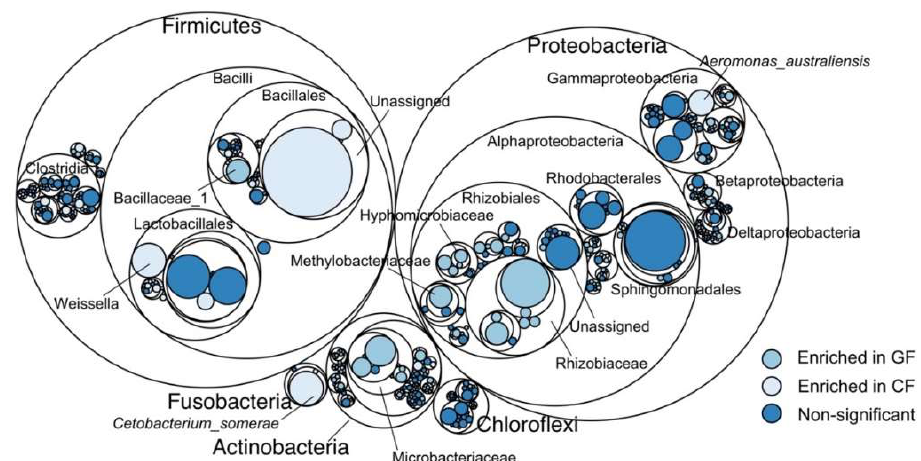
Figure 3. Maptree plot descriptions of the taxonomic differences based on 16S rRNA sequences. The largest circles represent phyla level, the inner circles represent class, order, family, and genus for panel.